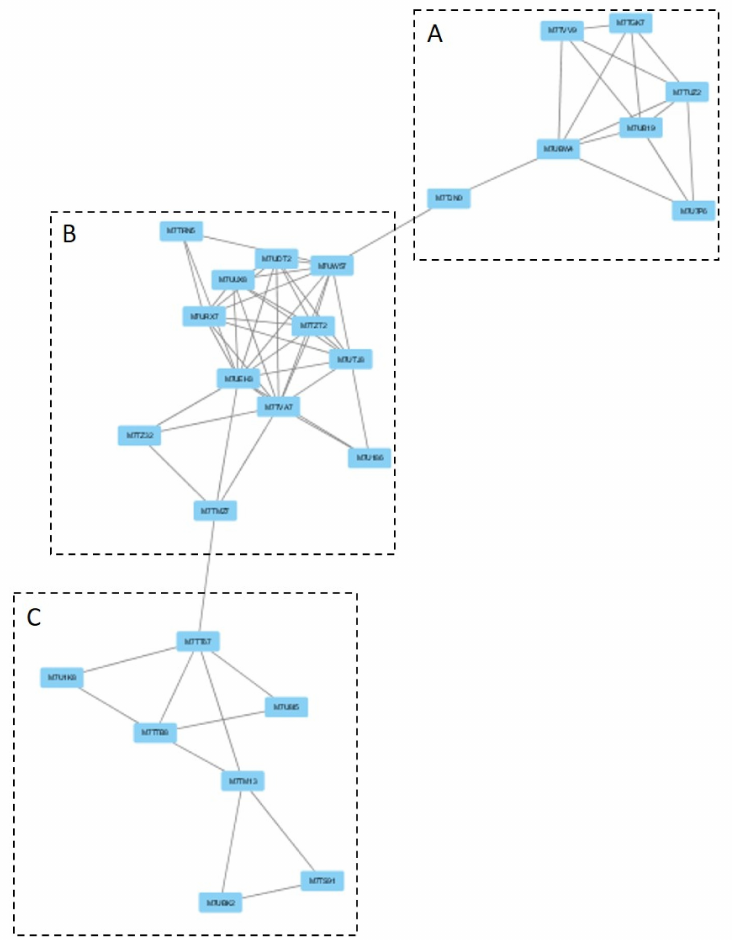
Figure 7. Cluster 10: toxin production cluster under the GLU condition. Clusters were obtained analyzing STRING networks of protein, exclusively identified or overexpressed in B. cinerea proteomes (membranome, phosphoproteome, phosphomembranome, and secretome) under GLU with